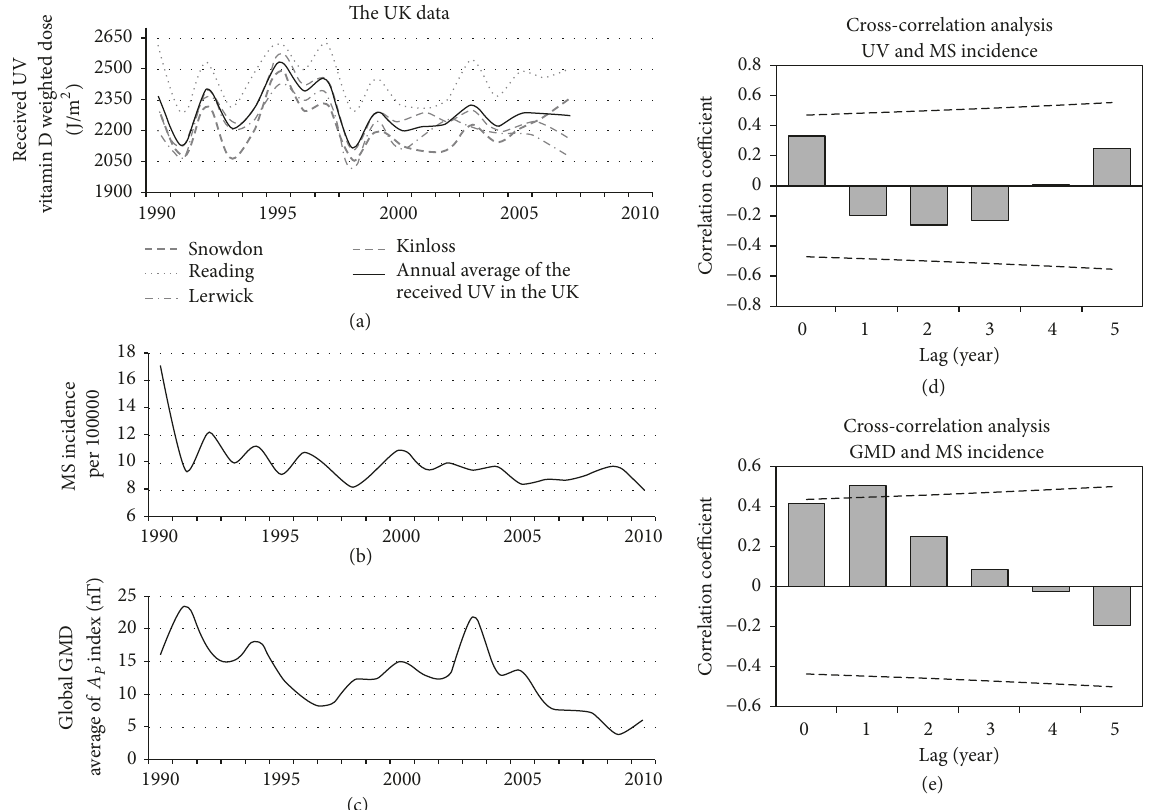
Figure 8: The UK data. Panel (a): the black line shows the annual average of the received UV (1990–2007) calculated from the data of the four sites throughout the UK (bright gray lines). Panel (b): MS incidence of the UK (1990–2010), adapted from the report of Mackenzie et al. [17]. Panel (c): annual average of global GMD based on the 𝐴 𝑝 index (1990–2010). Panel (d): the result of lagged correlation between received UV and MS incidence. Panel (e): the result of lagged correlation between GMD and MS incidence. The dashed lines in those panels (d and e) are the threshold for significant correlation. The horizontal solid lines in these panels indicate coefficient of correlation (𝑟) = 0